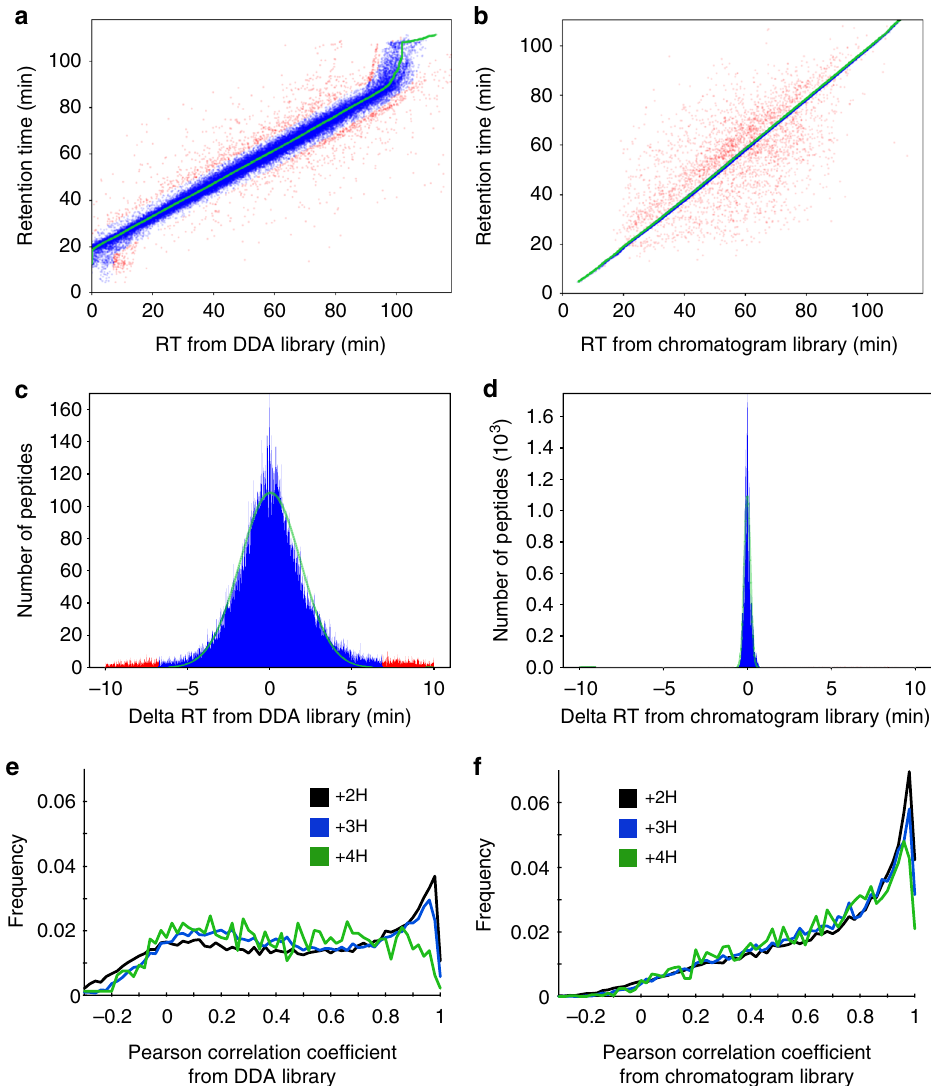
Fig. 4 Retention time and fragmentation accuracy of spectrum and chromatogram libraries. Scatterplots comparing retention times (RT) from the a DDA spectrum library and the b DIA chromatogram library to those from in a single HeLa DIA experiment. Each point represents a peptide, where blue peptides fi t the retention time trend (green) within a Bayesian mixture model probability of 5% and red peptides are outliers (see Methods section for more details). c Delta RTs in the DDA spectrum library are 95% accurate to a window of 5.1 min, while d retention times in the chromatogram library are 95% accurate to 21 s. e The distribution of Pearson correlation coef fi cients between spectra in the DDA spectrum library and those detected from a single HeLa DIA experiment shows charge state bias, while f the distribution of correlation coef fi cients between spectra in the DIA chromatogram library and those from the same experiment shows much less